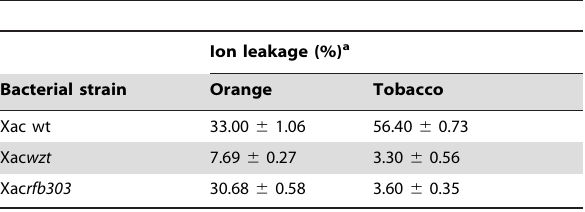
Table 3. Cell membrane injuries of orange and tobacco leaves produced by bacterial